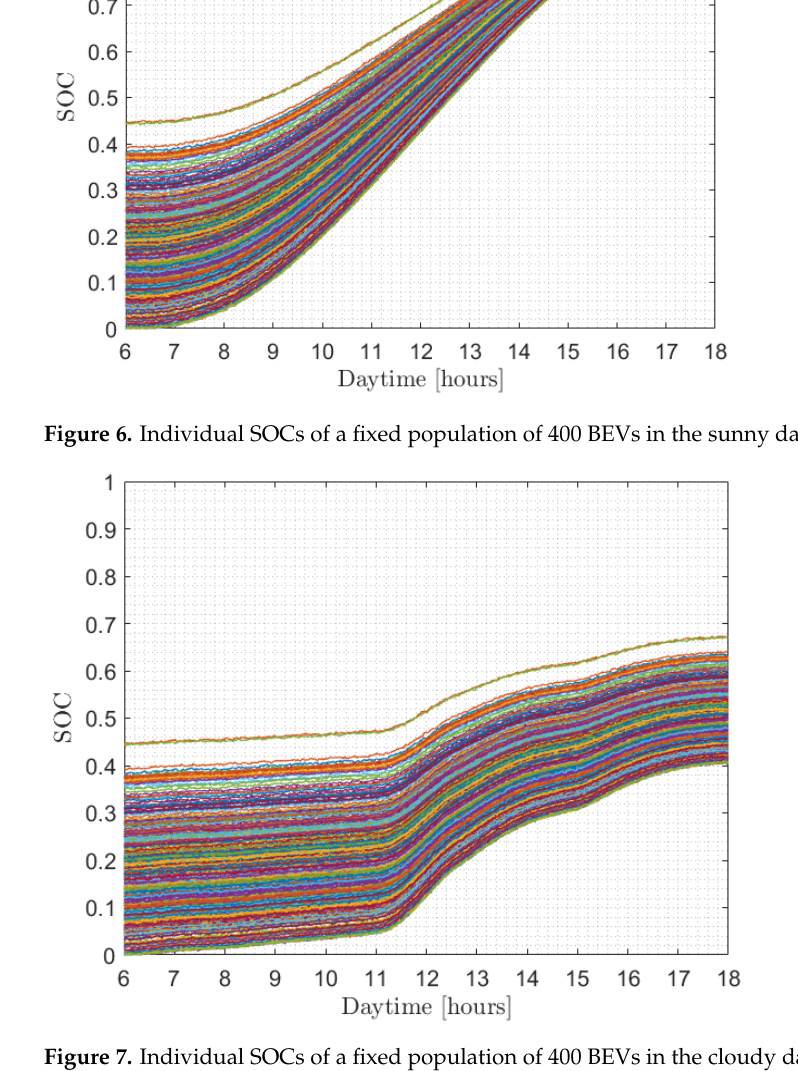
Figure 7. Individual SOCs of a fixed population of 400 BEVs in the cloudy